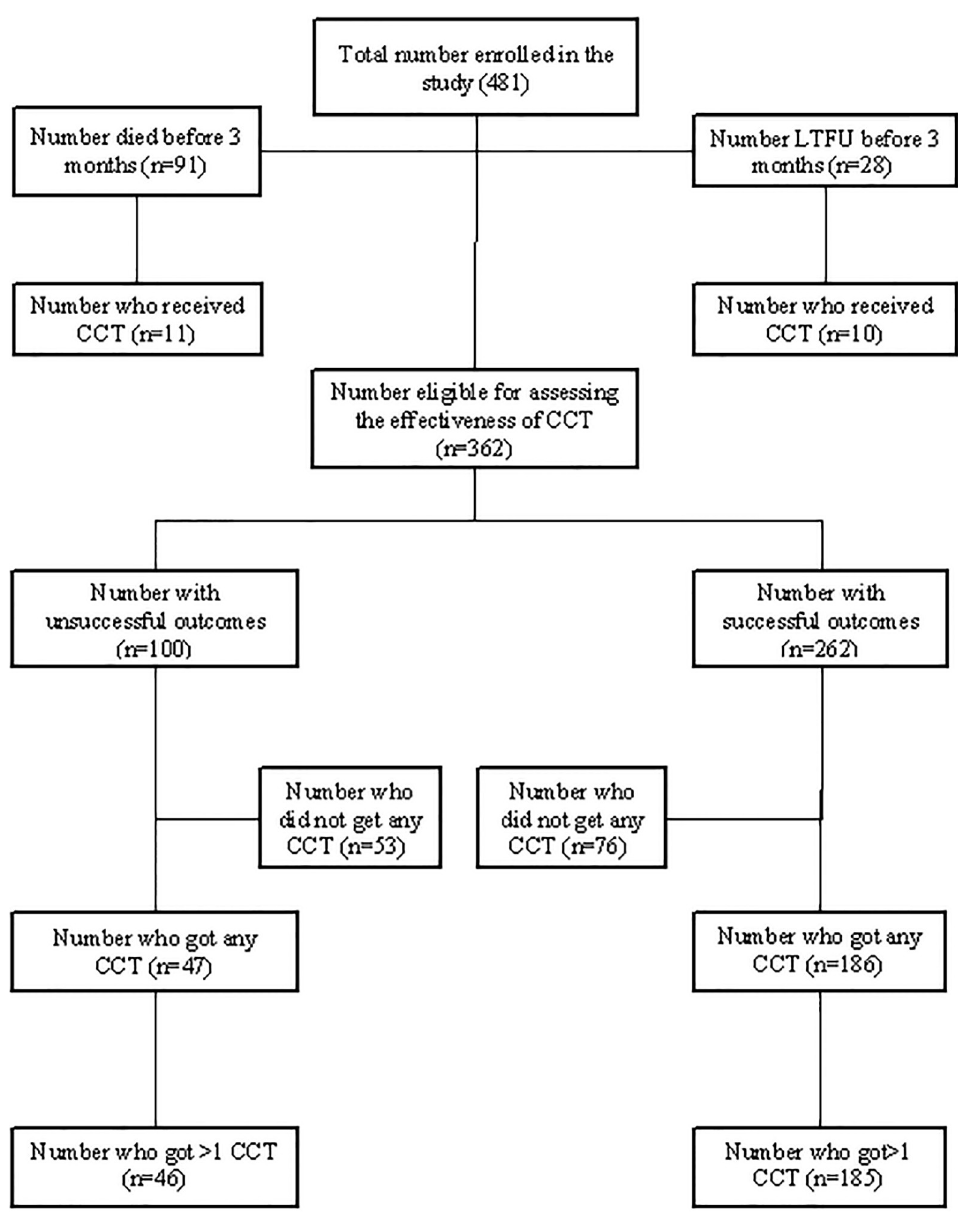
Fig 2. Flowchart for people with DR-TB whose records were included in the study, 2014–2021,